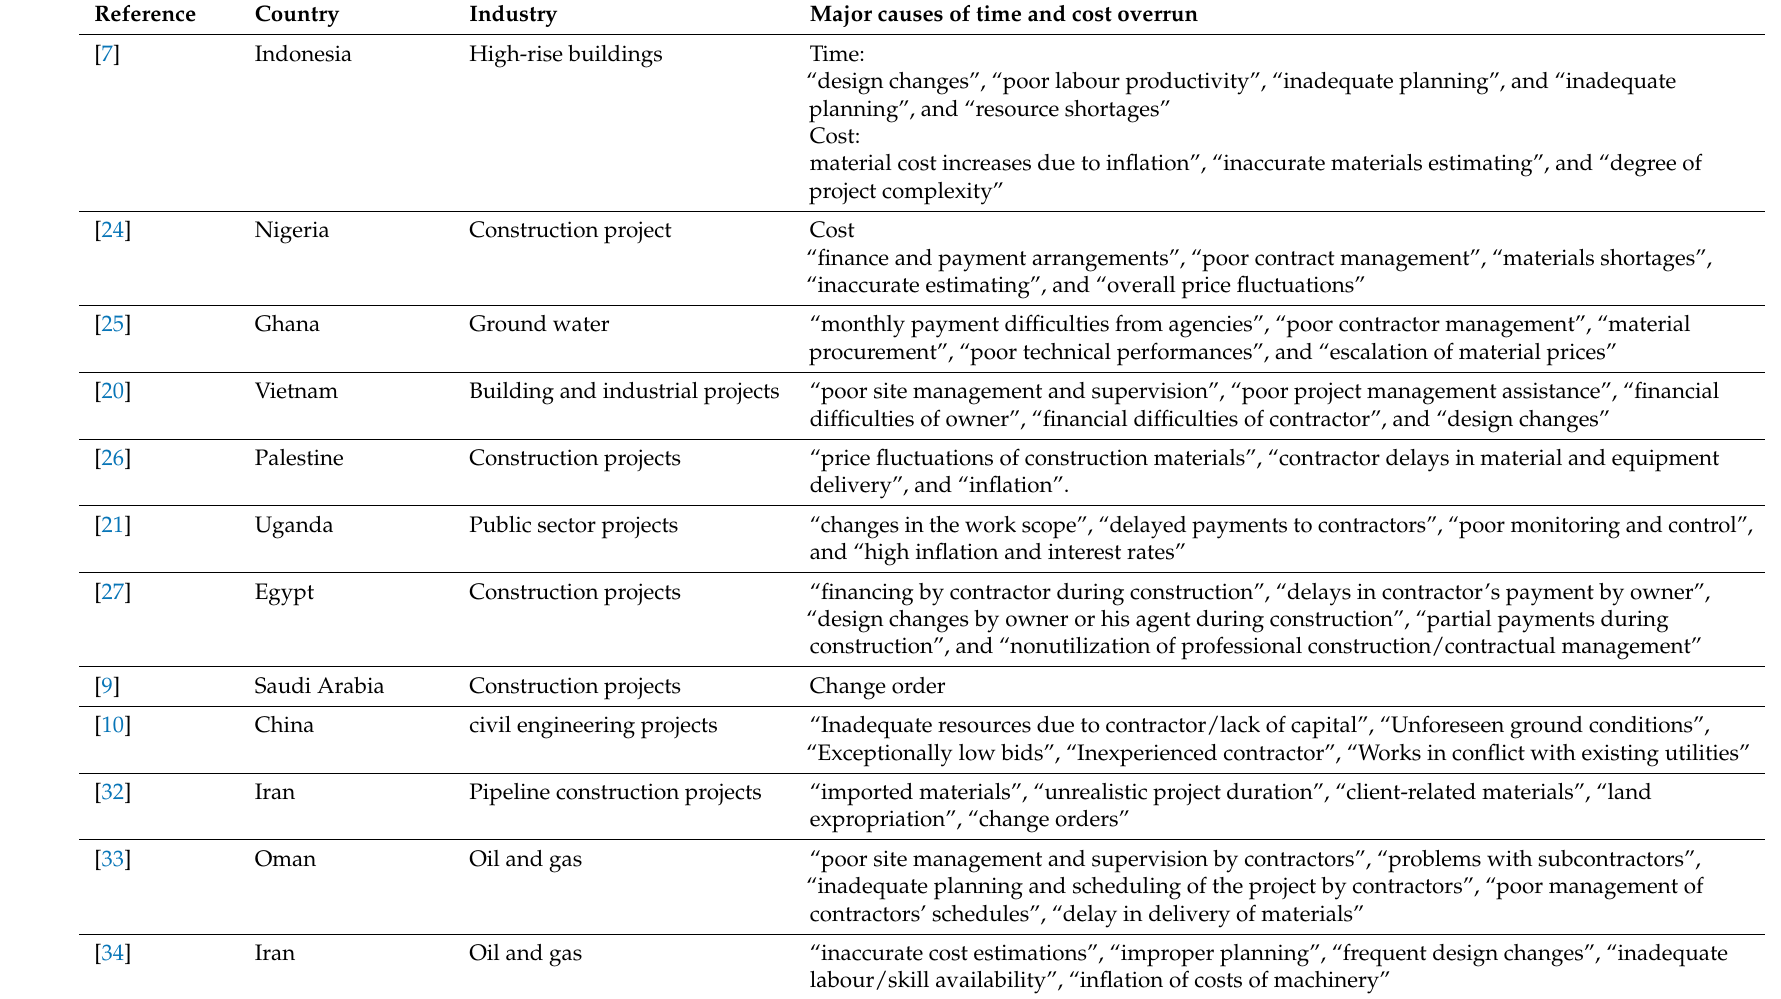
Table 1. Summary of major causes of time and cost overrun in the reviewed